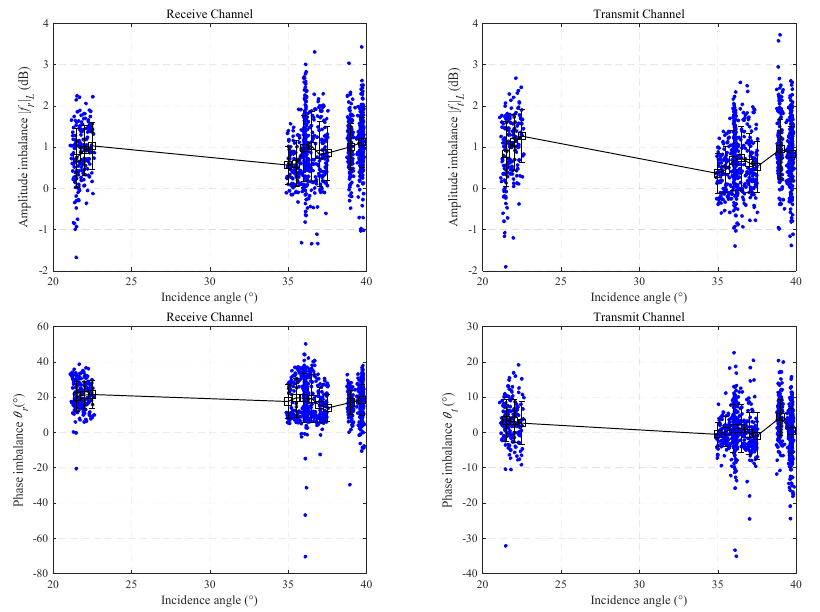
Figure 5. The amplitude and phase imbalance variation relative to incidence angle. Same with Figure